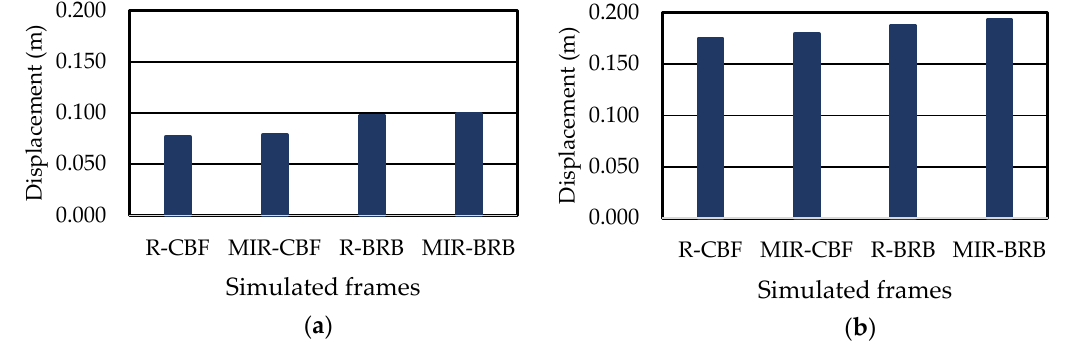
Figure 6. Average displacement comparison of ( a ) 10-story frames and ( b ) 15-story frames.